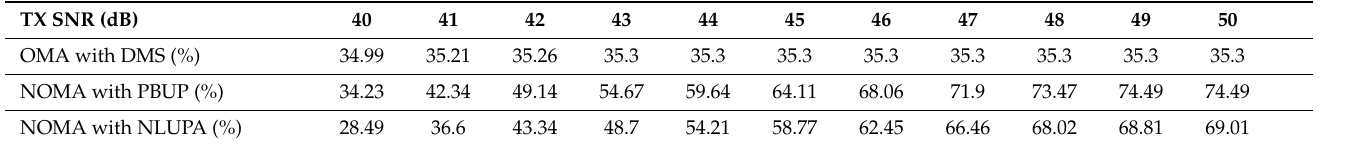
Table 7. Packet delivery